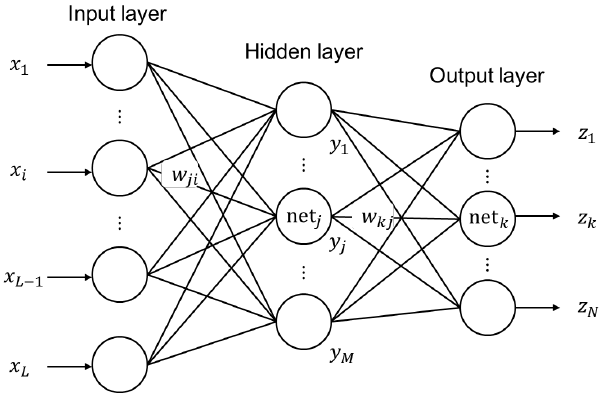
Figure 5. Multi-layer perceptron.